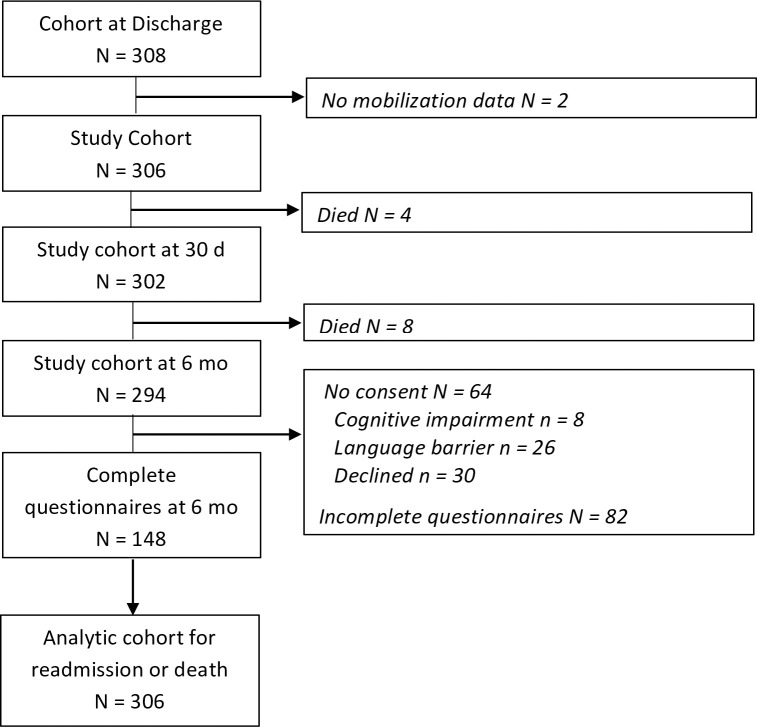
Flow diagram of cohort.